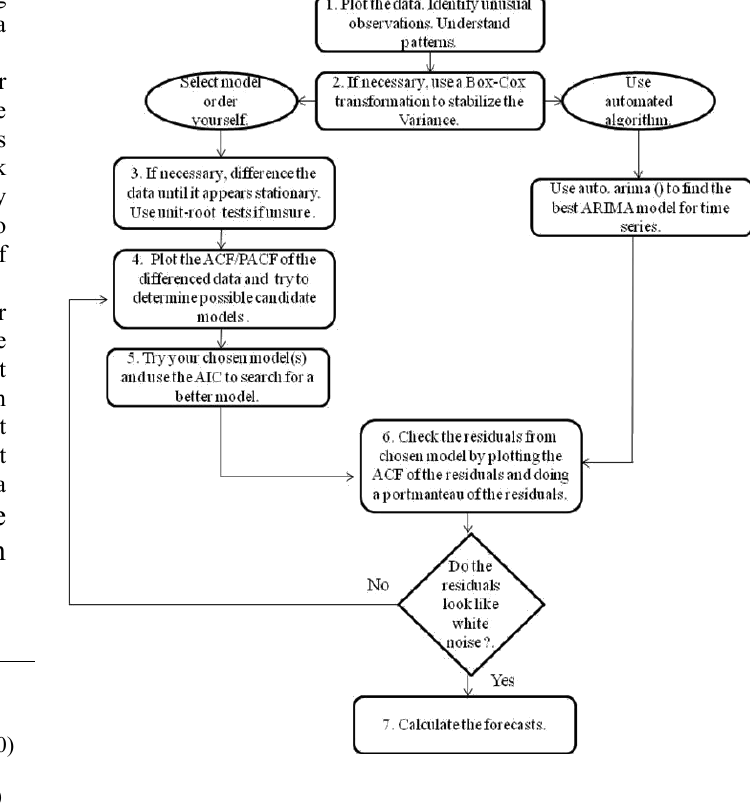
Figure 5. Modelling Procedure for